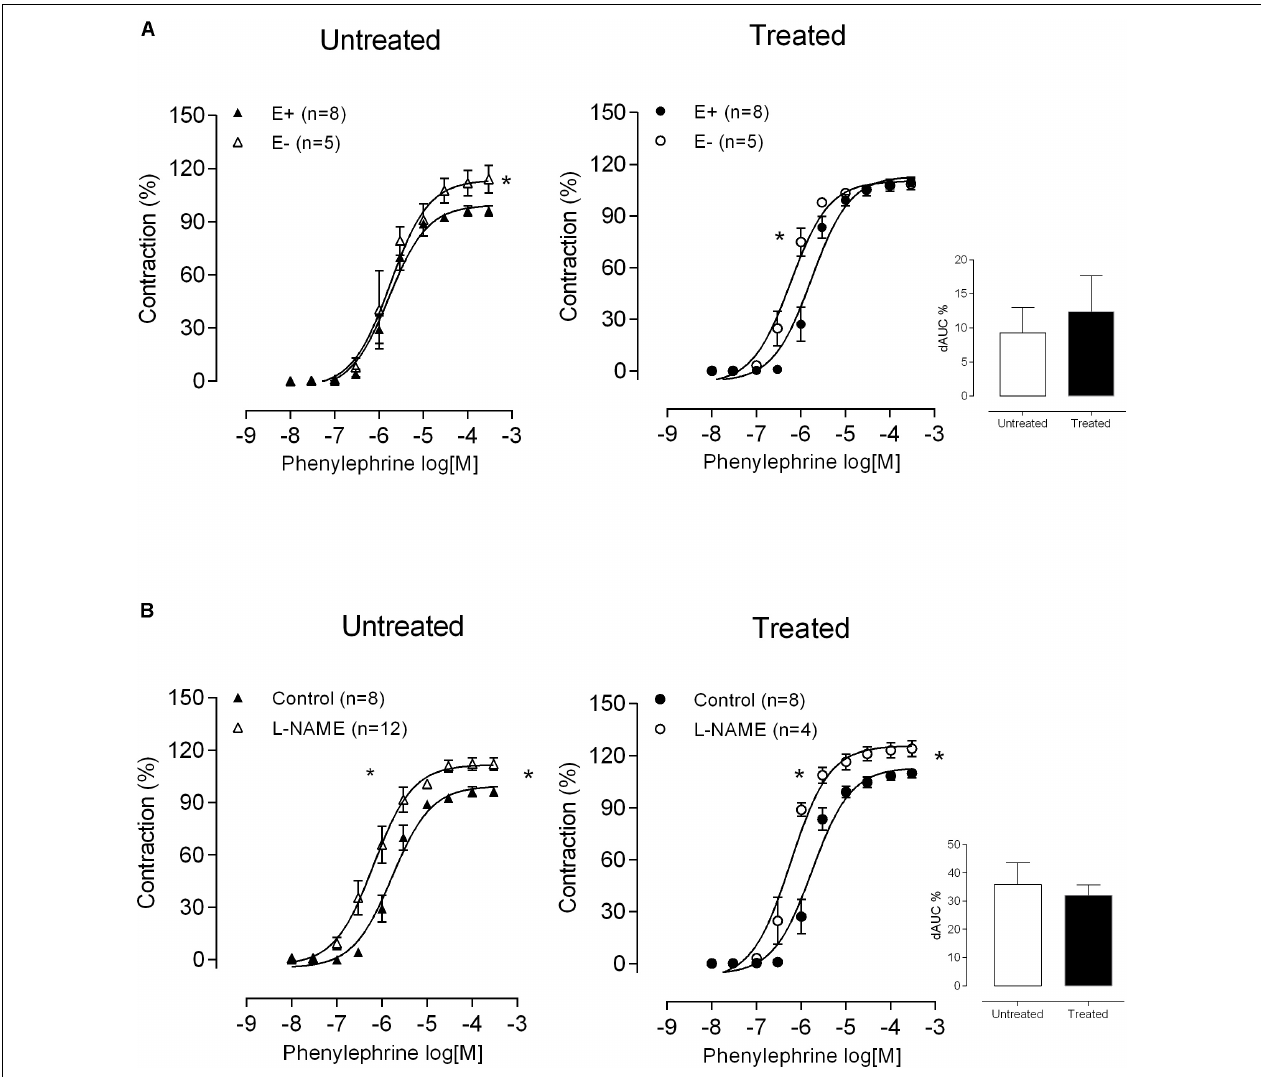
FIGURE 2 | Role of nitric oxide in altered phenylephrine responses after lead treatment. The effects of (A) endothelium removal (E − ) and (B) L-NAME (100 µ M) on the concentration-response curve to phenylephrine in mesenteric rings from untreated and treated rats. * P < 0.05 versus E + or control using two-way ANOVA and Bonferroni post-test. The insert shows differences in the area under the concentration-response curves (dAUC) in denuded and intact endothelium segments and in the presence and absence of L-NAME. * P < 0.05 versus untreated by Student’s t -test. Data are expressed as the mean ± SEM. n denotes the number of animals